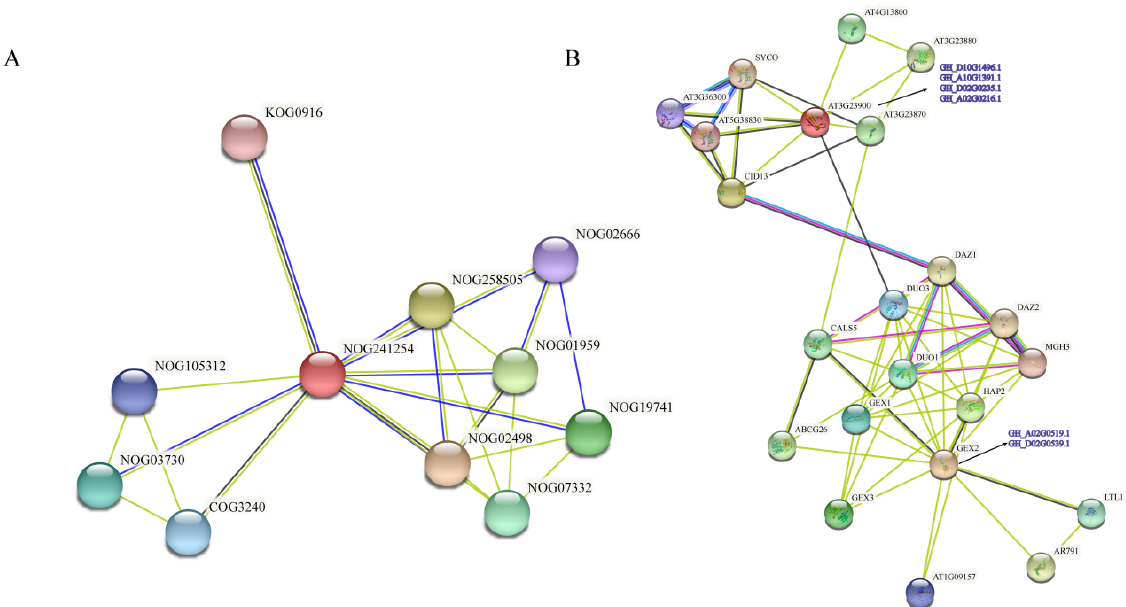
Figure 11. Interaction networks of filamin proteins. ( A ) Interaction network of filamin protein families. ( B ) Interaction network of filamin proteins in cotton with other proteins. The blue letters represent filamin proteins of upland cotton.